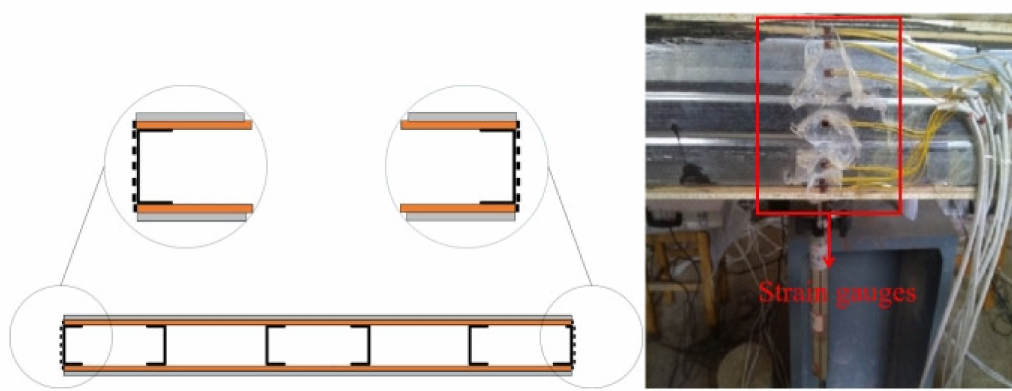
Figure 9. Position of strain gauges in mid-span section of LSF